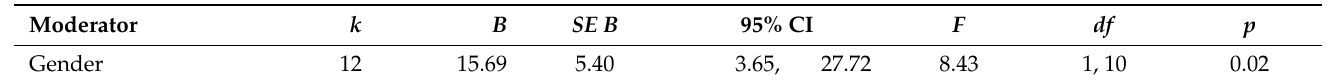
Table A5. Separate Regression Analyses for the Moderators Predicting Reliability Scores of the Relational Provisions Loneliness Questionnaire (RPLQ).